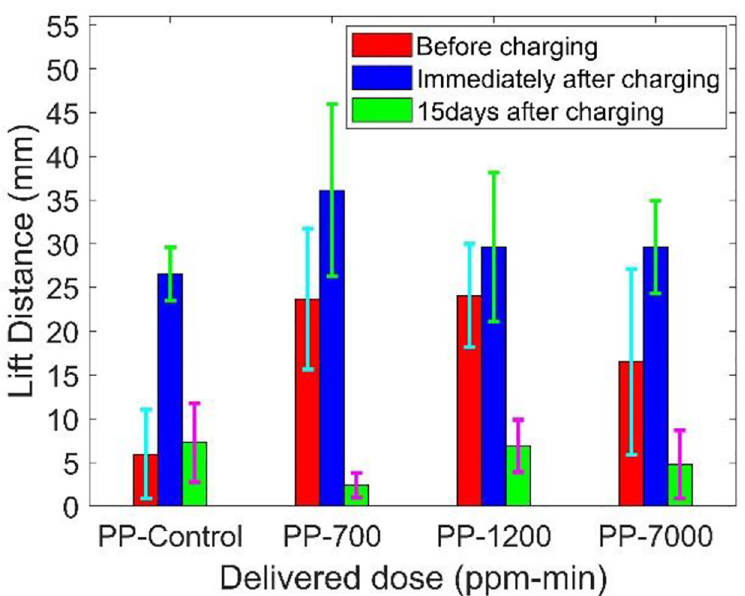
Fig 20. Surface charge measurement of polypropylene material treated by Plasma